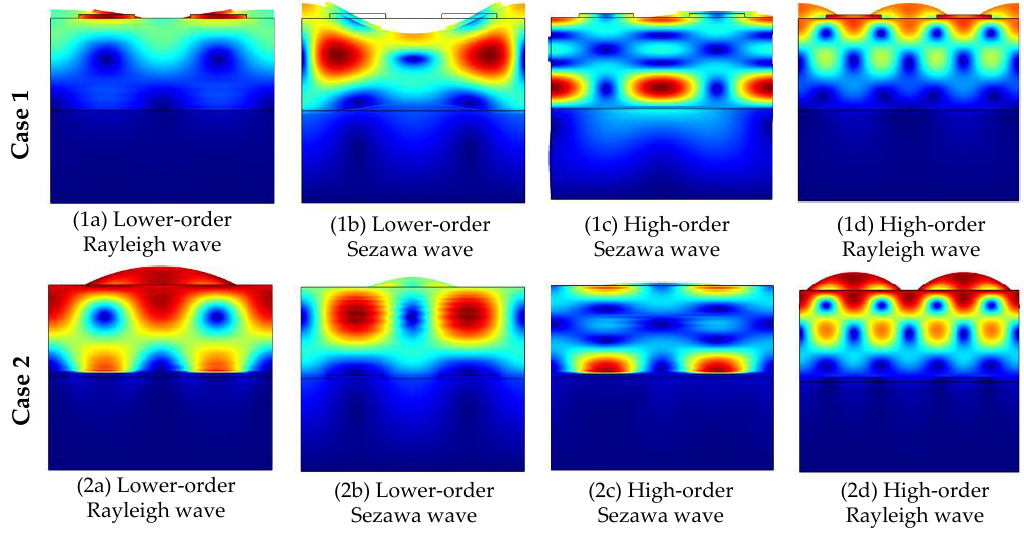
Figure 11. Modal waveforms for different cases.